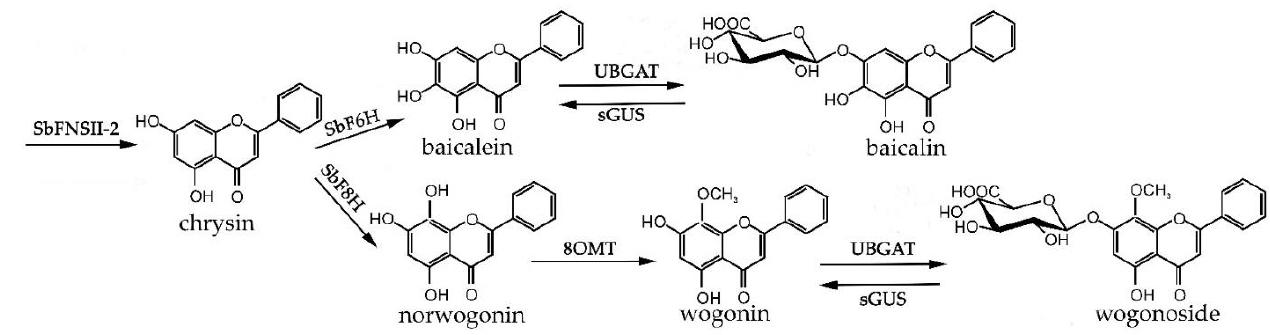
Figure 3. The pathways for synthesis of root-specific flavones (flavones-synthase II (SbFNSII-2) [8], flavones-6-hydroxylase (SbF6H) [39], flavones-8-hydroxylase (SbF8H) [39], 8- O -methyltransferase (8OMT) [40], baicalein 7- O -glucuronosyltransferase (UBGAT) [41], sGUS—baicalinase, β -glucuronidase [42]). According to the content of flavones, plant species form a series on both solid and liquid media: S. przewalskii > S. baicalensis > S. pycnoclada > S. lateriflora (Figure 4).